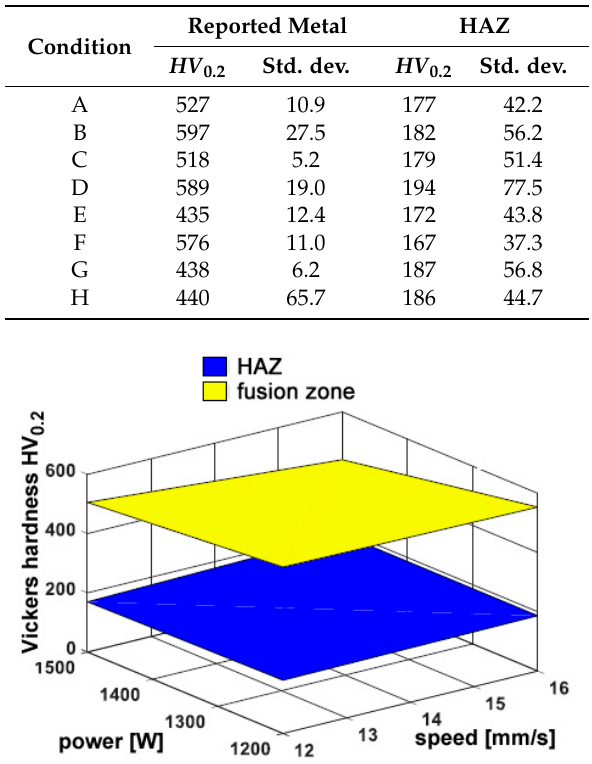
Figure 15. Average Vickers micro-hardness in the deposited metal; edge deposition.